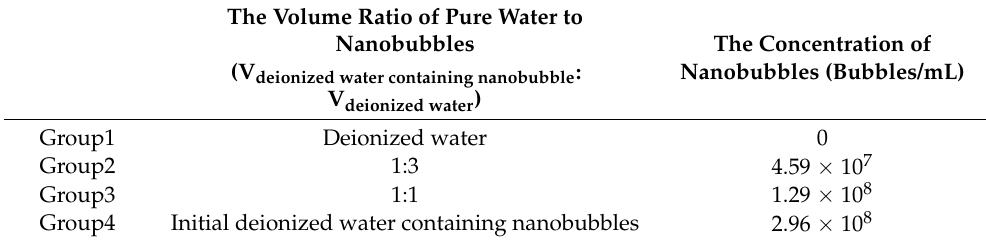
The Volume Ratio of Pure Water